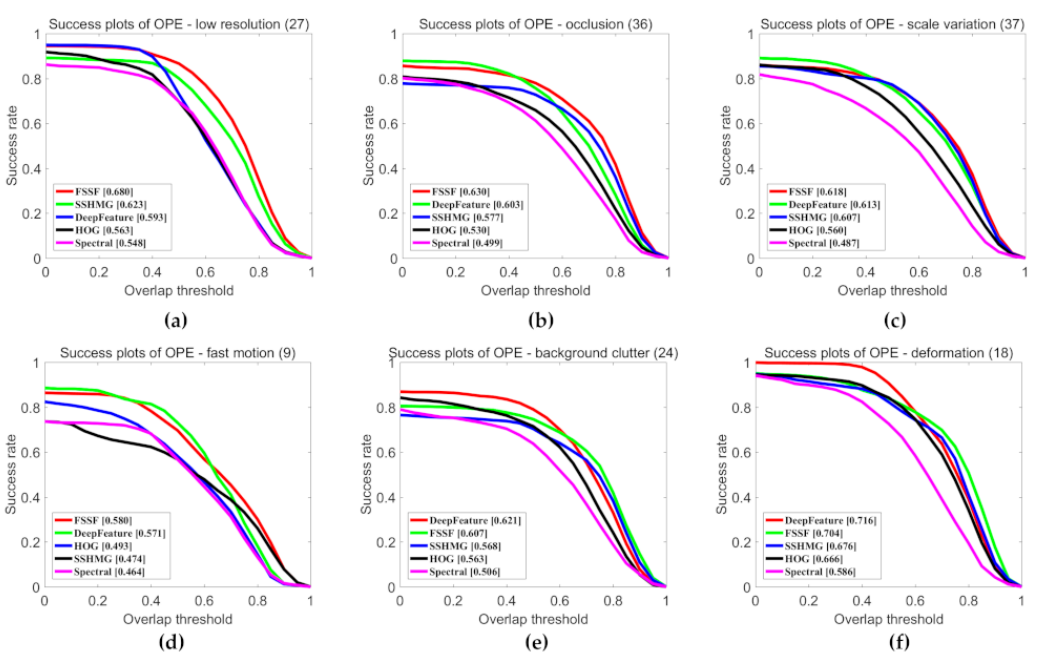
Figure 17. Success plots over six tracking attributes, including ( a ) low resolution (27), ( b ) occlusion (36), ( c ) scale variation (37), ( d ) fast motion (9), ( e ) background clutter (24), ( f ) deformation (18). The values in parentheses indicate the number of sequences associated with each attribute. The legend reports the area-under-the-curve score.